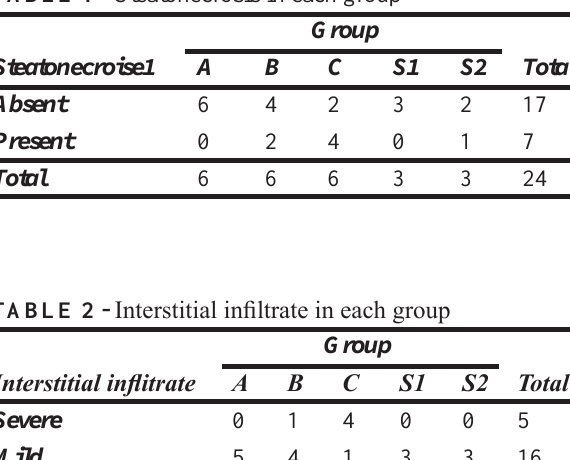
TABLE 1 - Steatonecrosis in each group